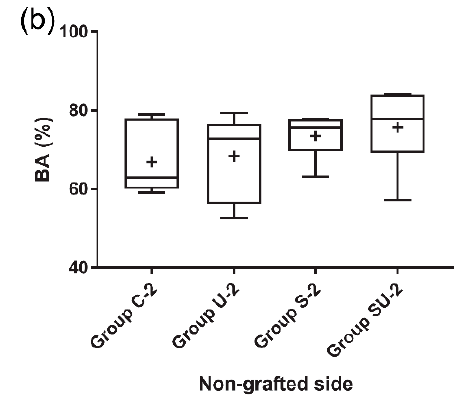
Figure 7. Representative photomicrographs (40× magnification) of hematoxylin and eosin-stained histological sections of rabbit tibias at the implanted regions. ( a ) Group C-2, nongrafted side; ( b ) Group C-2, grafted side; ( c ) Group SU-2, nongrafted side; ( d ) Group SU-2, grafted side; ( e ) Group C-4, nongrafted side; ( f ) Group C-4, grafted side; ( g ) Group SU-4, nongrafted side; and ( h ) Group SU-4, grafted side. Note the sparse amount of new bone on the grafted side in 2-week groups. Scale bars: 500 μ m.